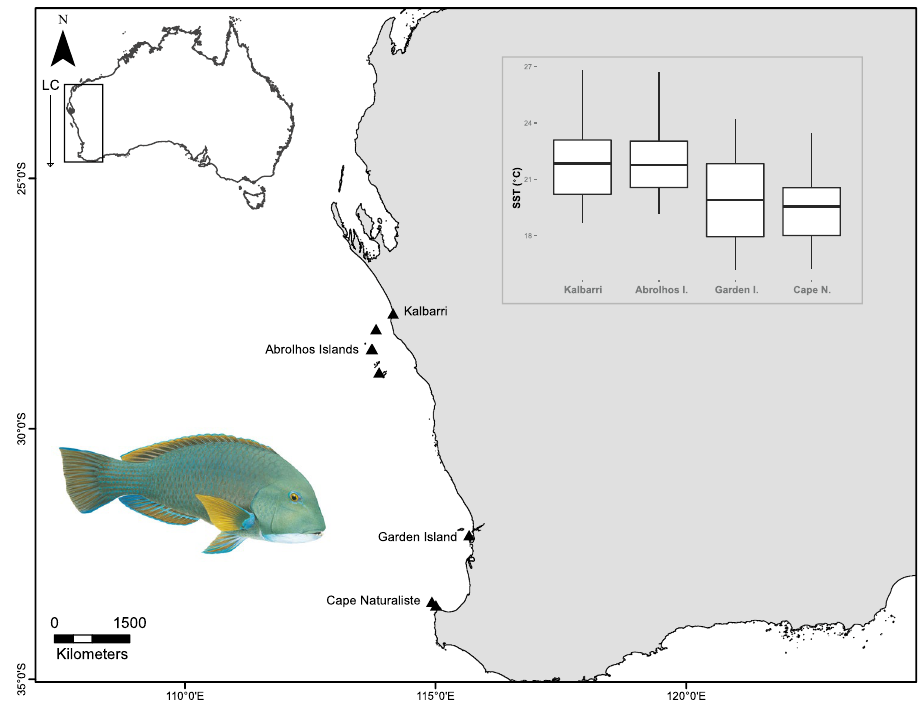
Figure 1. Map of Western Australia (WA) showing locations sampled across the geographical range of Choerodon rubescens (triangles represent reefs sampled within locations). Geographical range is represented by a square inset over the map of Australia in the top left corner. Boxplot inset shows long-term monthly average sea surface temperatures (SST °C) at each location; data from MODIS-AQUA satellite (Goddard Earth Sciences Data and Information Services Center GES DISC, NASA); solid black lines represent median SST (2002–2013) and box boundaries upper and lower quartiles. LC: Leeuwin Current flow along the WA coast. C . rubescens illustration © R.